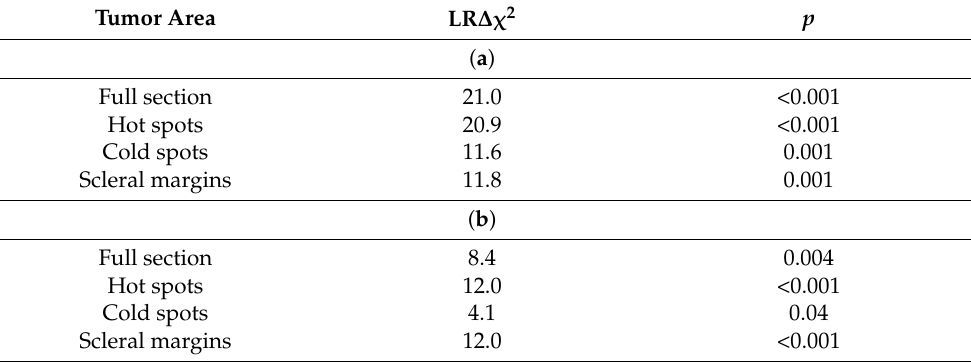
Table 4. ( a ). Likelihood ratio chi-square change (LR ∆ χ 2 ) for metastasis when adding BAP-1 ex- pression to American Joint Committee on Cancer (AJCC) tumor size category. ( b ). Likelihood ratio chi-square change (LR ∆ χ 2 ) for metastasis when adding BAP-1 expression to gene expression class. Tumor